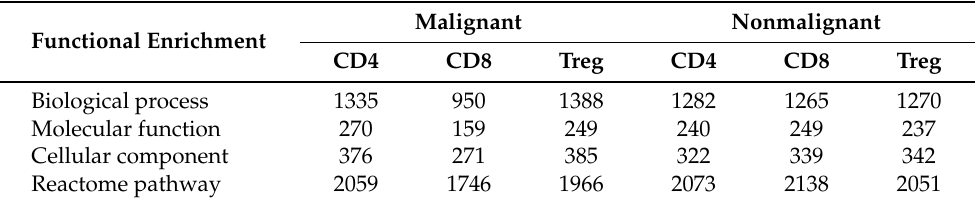
Table 2. Summary of functional enrichment annotations for malignant and nonmalignant CD4-T, CD8-T and Treg